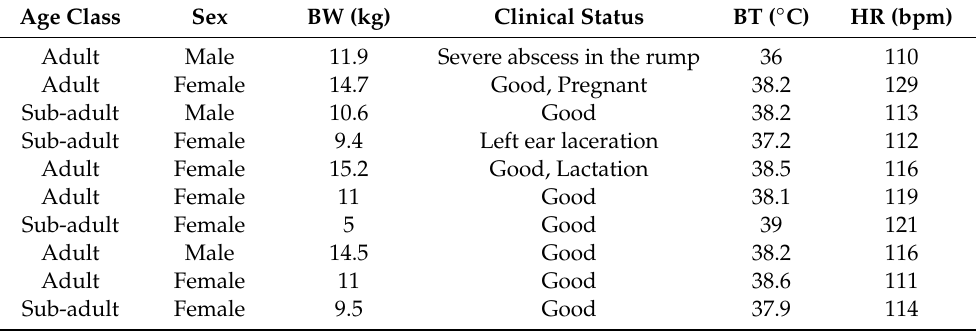
Table 1. Age class, sex, body weight (BW), clinical status, body temperature (BT), and heart rate (HR) of each captured porcupine from which blood samples were collected and analyzed.